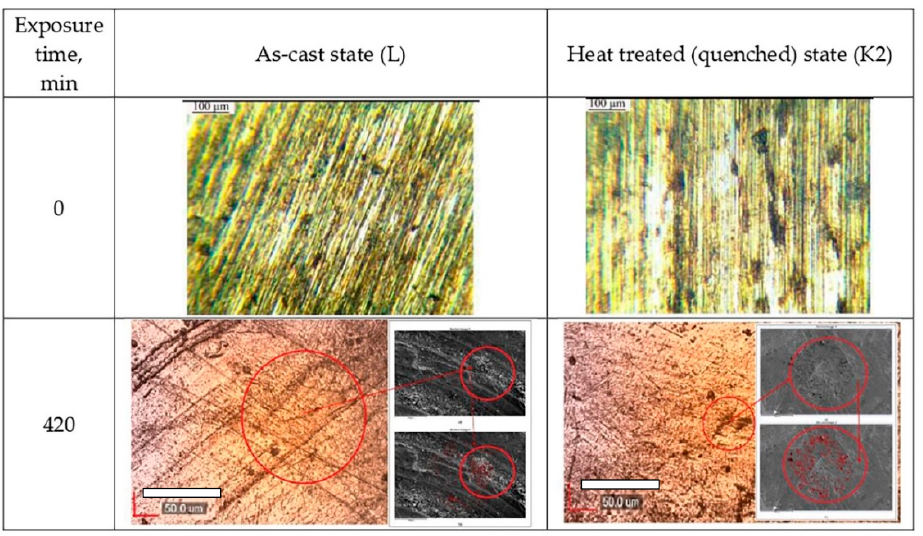
Figure 4. Micrographs of samples before and after 420 min of cavitation exposure.